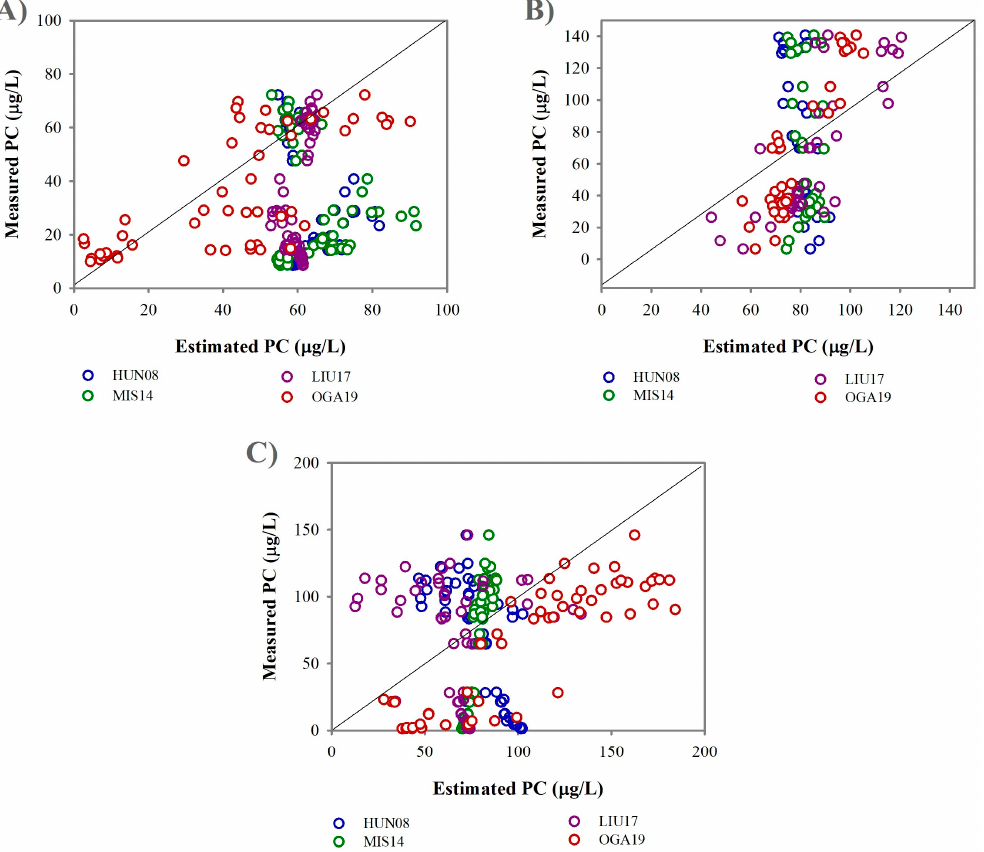
Figure 4. Validation of the semi-empirical algorithms using 2010 datasets for ECR ( A ), GR ( B ), and MR ( C ). Table 5. Comparison of error metrics among different semi-empirical algorithms.